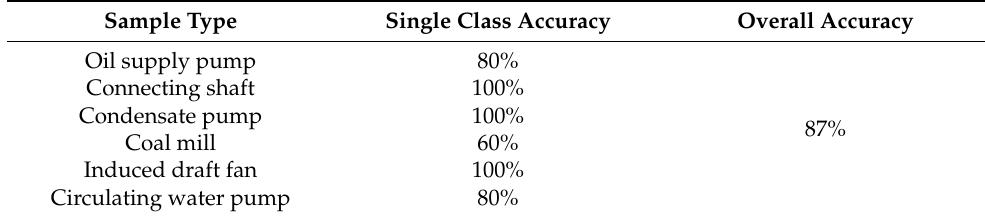
Table 3. Add white noise data classification